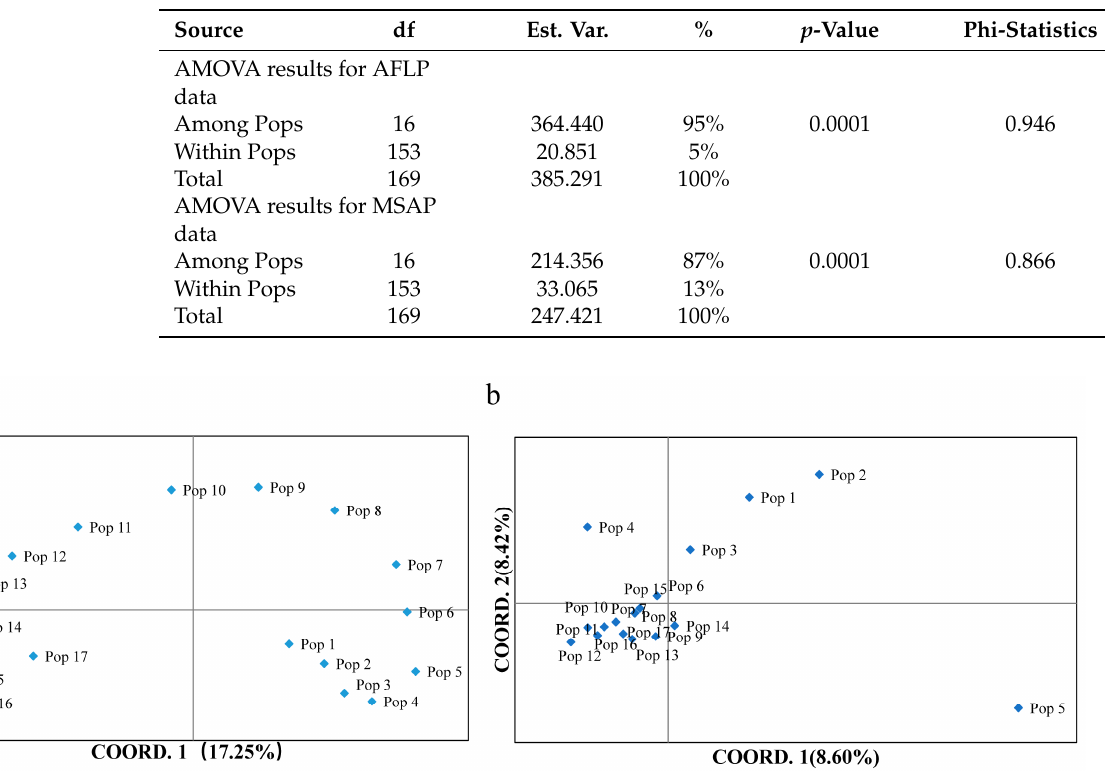
Figure 1. Principal coordinates analyses (PCoA) of Nei’s genetic distance ( a ) and Nei’s epigenetic distance ( b ) of different populations of D. angustifolia.